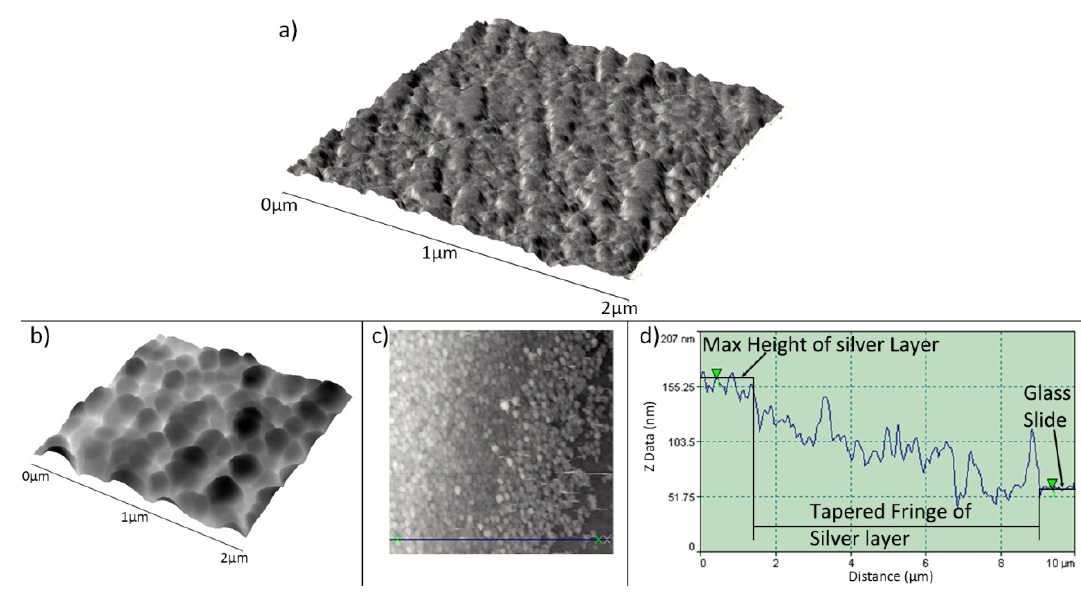
Figure 9. ( a ) Mesoporous structure of anatase TiO silver metal grains within a silver layer deposited on a TiO ( c ) AFM image of the silver layer/glass slide fringe. ( d ) AFM topography step height measurement over a distance of 9.10 µm and a height change of 104.8